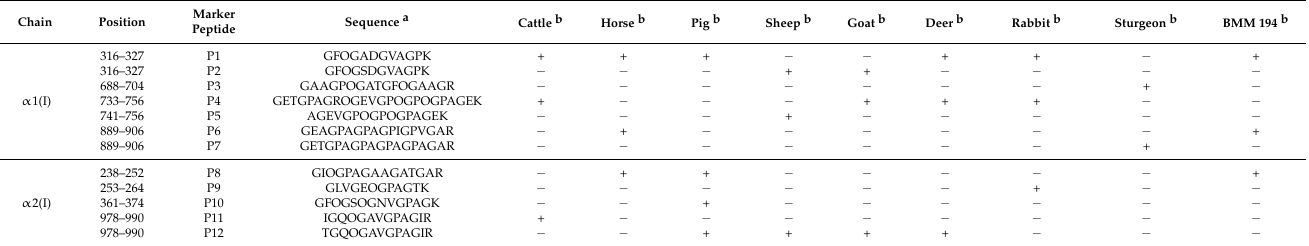
a O indicates 4-hydroxyproline. b The presence and absence of marker peptides are denoted by + and − ,